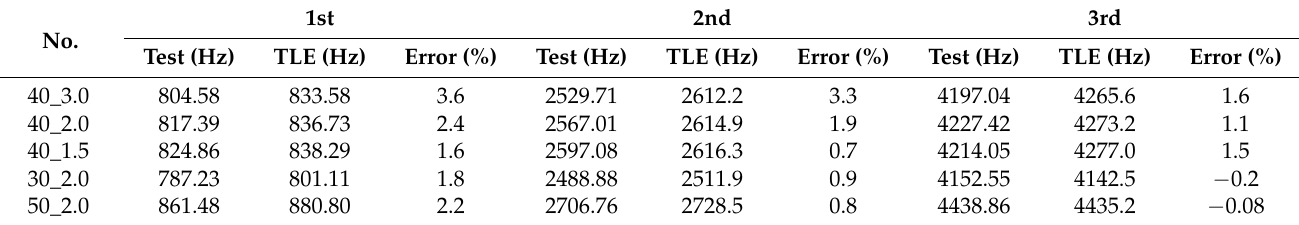
Table 7. First three order frequencies of the threaded tubes in the experiments and TLE method (source elaborated by authors).